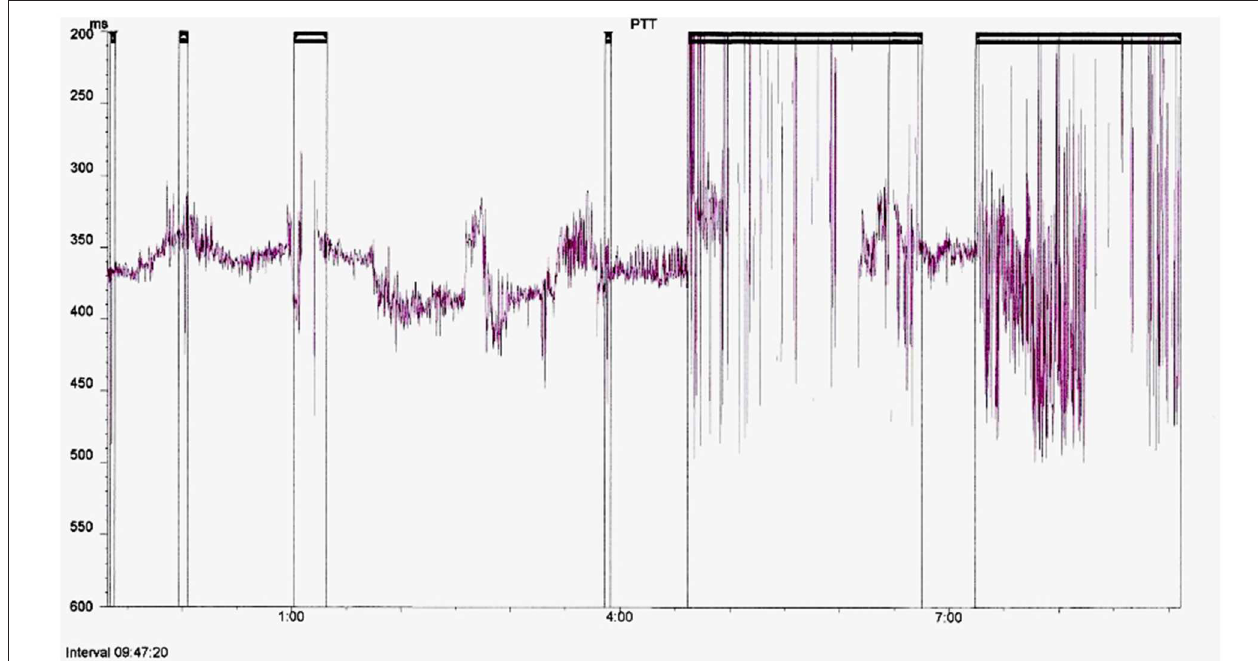
FIGURE 3 | Example of a full study PTT montage with artifact highlighted for exclusion from analysis.